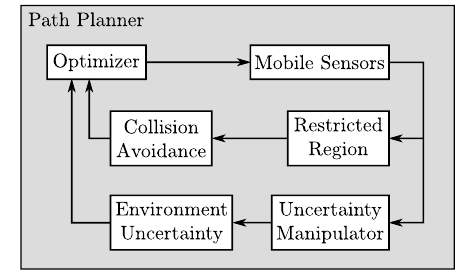
Figure 3: Conceptual modules in the path